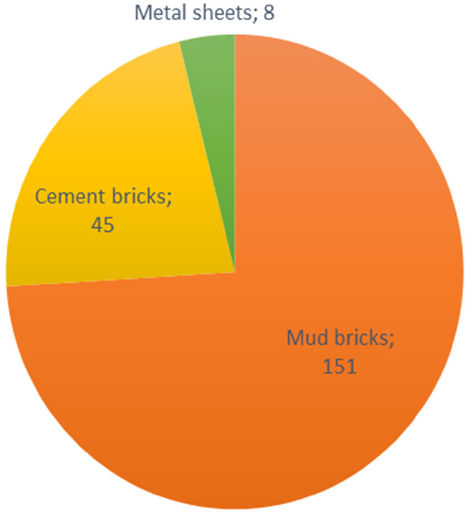
Figure 4. Material of housing walls of participants. Source: Fieldwork. An area in Rokupa was seen to be potentially exposed to high tides and coastal flooding due to the deforestation of the mangrove plantation (Figure 5).